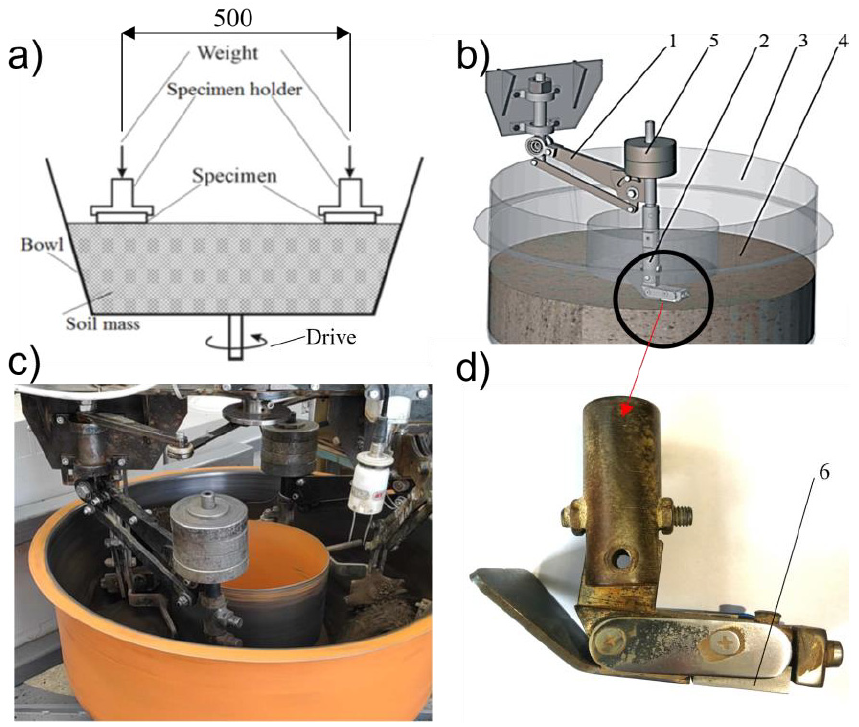
Figure 1. A “rotating bowl” test stand: ( a ) the principle of operation; ( b ) a scheme of one working section: 1—swingarm, 2—specimen holder, 3—bowl with abrasive mass 4, 5—weight, 6—specimen; ( c ) general view; ( d ) specimen holder.